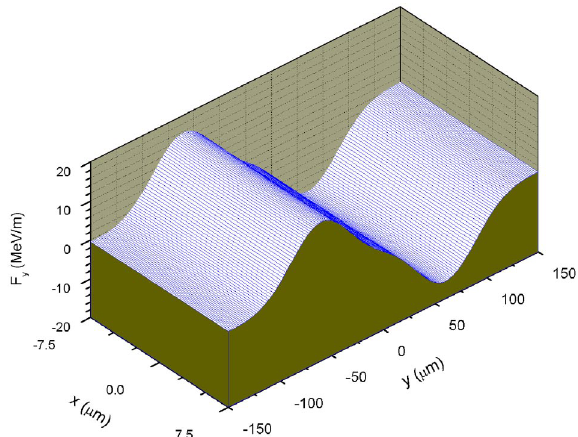
FIG. 12. (Color) Dependence of F on x and y at z (cid:3) y is focusing in the y direction in the region of 1009 : 2 (cid:4) m . F y j y j < 131 : 6 (cid:4) m , leading to a common region of j x j < 7 : 5 (cid:4) m and F are focusing. and j y j < 60 : 4 (cid:4) m , where both F x y